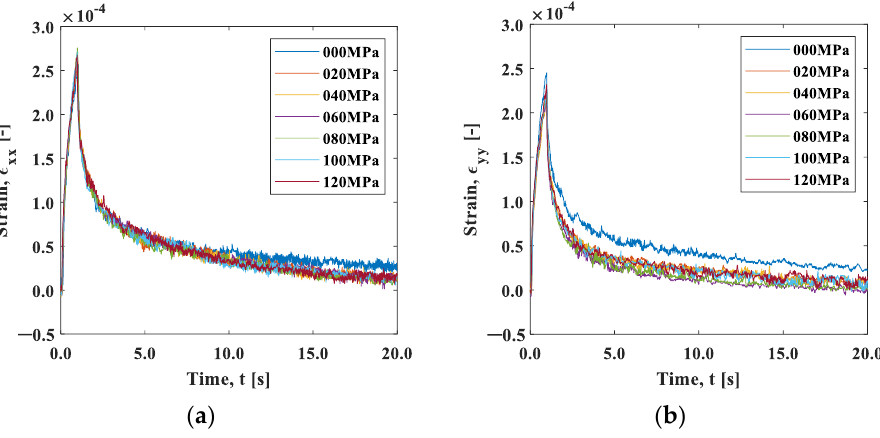
Figure 16. Strain – time curve obtained using the ESPI: ( a ) 𝑥 -direction; and ( b ) 𝑦 -direction. Here, the stress dependences can be discussed in the same manner as the strain gauge measurement. Figure 17 shows the natural logarithm of the strain. The first-order approximation of the curve for 0.4 s after heating and the slope for each stress are shown in Figure 18. The strain relaxation coefficient obtained by the ESPI measurement showed stress dependency, similar to the strain gauge measurement; the CSR in the 𝑦 -direction decreased with the initial stress, and the CSR in the 𝑥 -direction and its aspect ratio also showed the same tendency as the strain gauge measurement. Furthermore, the maximum strain in the unheated area (area B) during the local heating test was plotted against the initial stress, as shown in Figure 19. It is confirmed that the nonthermal strain relaxation increased with increasing stress, although there was some scatter. The above results show that the ESPI allows the same residual stress analysis as the strain gauge measurement.